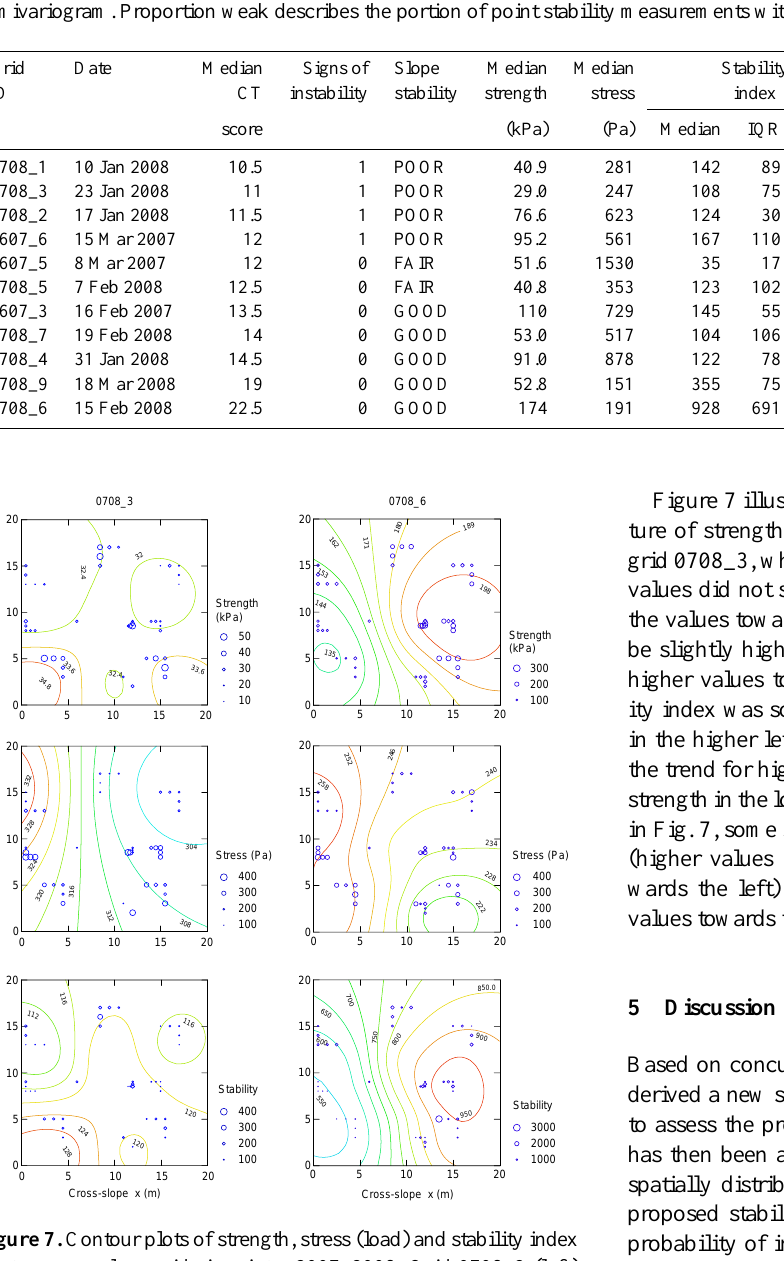
Table 3. Summary statistics for the 11 grids. For signs of instability, “1” indicates the presence and “0” the absence of whumpfs, shooting cracks or recent avalanches. For the stability index, the slope median, the interquartile range (IQR) and the quartile coefficient of variation (QCV) are given per grid. The range is a measure of autocorrelation and was determined by fitting a spherical model to the experimental semivariogram. Proportion weak describes the portion of point stability measurements with S ≤ 212.